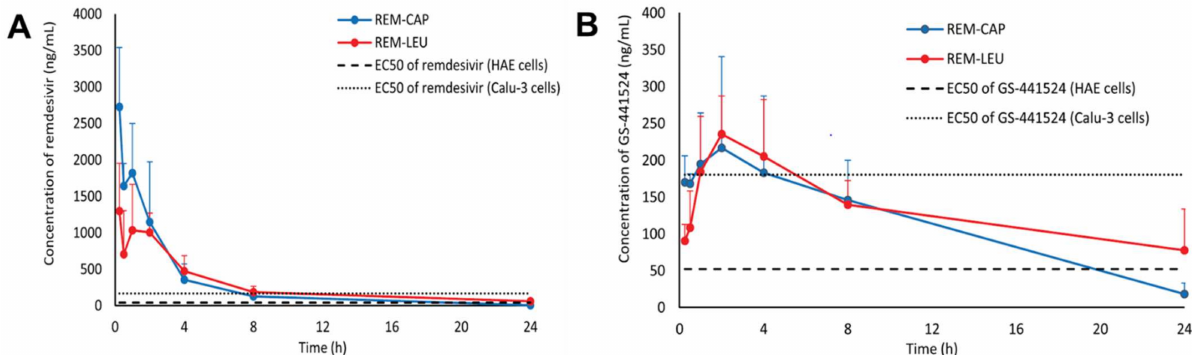
Figure 3. Plasma concentration–time profiles of REM-CAP (remdesivir-Captisol ® ; 80/20 w / w ) and REM-LEU (remdesivir-leucine; 80/20 w / w ) after a single inhalation administration in hamsters; ( A ) remdesivir; ( B ) GS-441524. The dashed line and dotted line represent the EC50 of remdesivir and GS-441524 in human epithelial cells (HAE) and a continuous human lung epithelial cell line (Calu-3), respectively. Reproduced from Sahakijpijarn et al. [46] with kind permission of copyright holder,